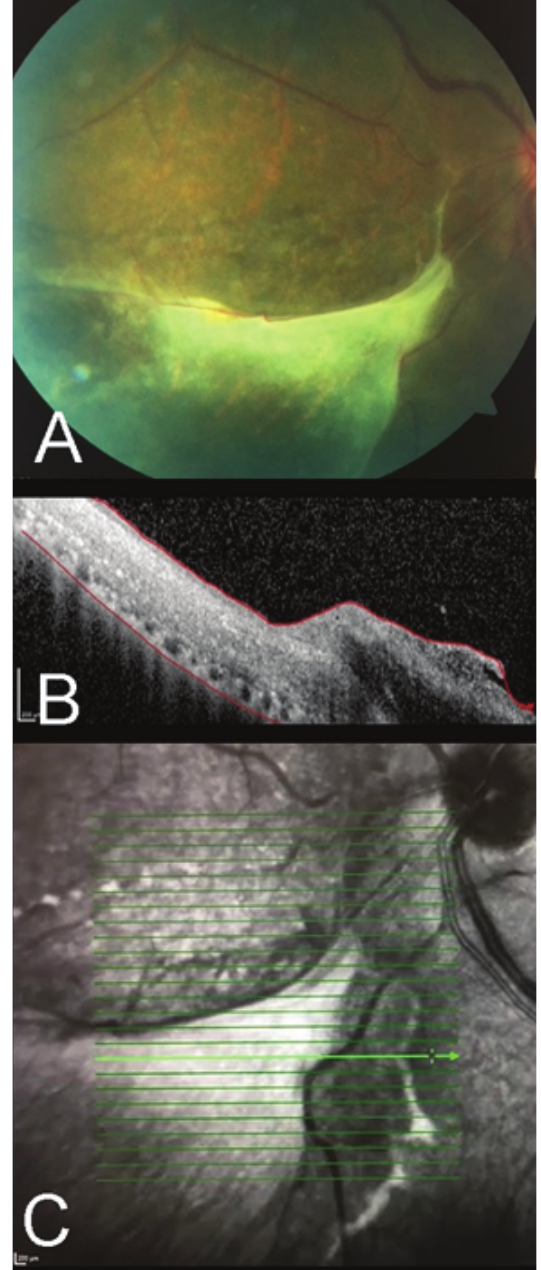
Figure 3. The inferonasal fundus photo of the left eye at 10 weeks showing preretinal fibrosis with a corresponding OCT (over the white lesion, see Arrow) showing an atrophic retina with resolved vitritis. A corresponding infrared image showing the line of scan of the